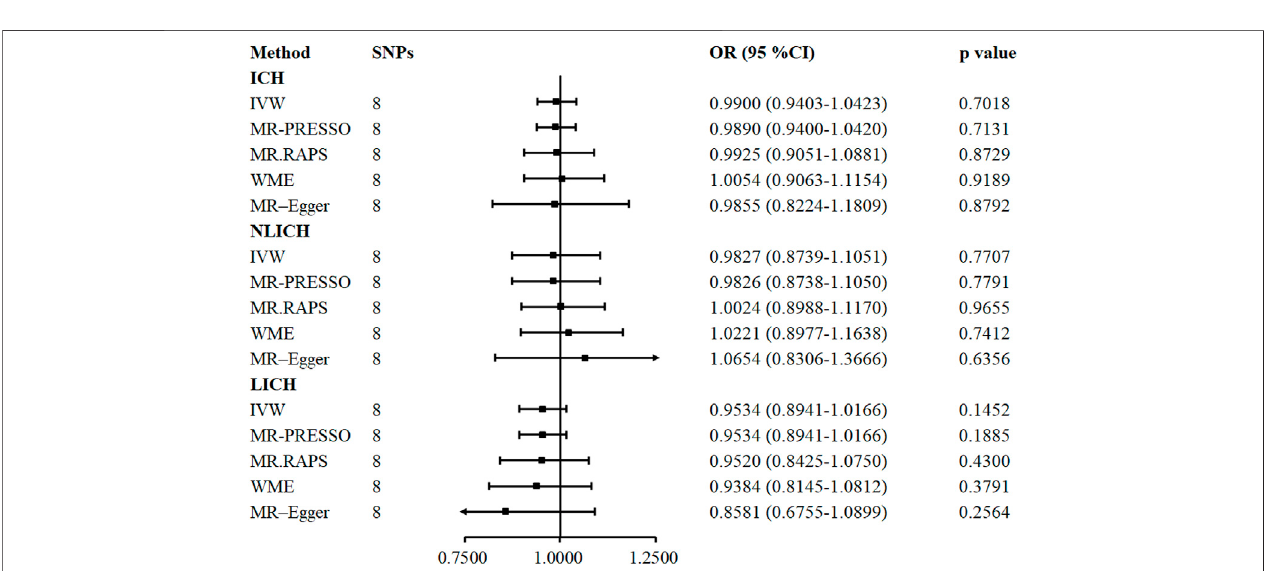
FIGURE 3 | Five methods to assess the causal role of TIMP-3 in the risk of ICH and its subtype. CI = con fi dence interval, IVW = inverse-variance-weighted, OR = odds ratio, SNP = single nucleotide polymorphism, ICH = intracerebral hemorrhage, NLICH = non-lobar intracerebral hemorrhage, LICH = lobar intracerebral hemorrhage. MR. RAPS = MR-Robust Adjusted Pro fi le Score, MR-PRESSO = MR pleiotropy residual sum and outlier.